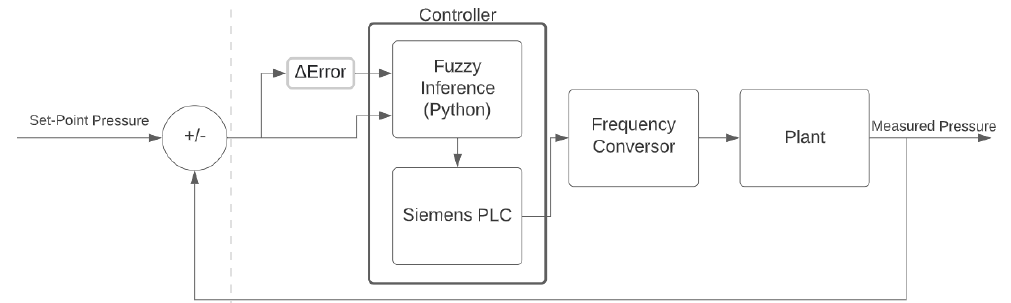
Figure 18. Fuzzy control diagram. Source: